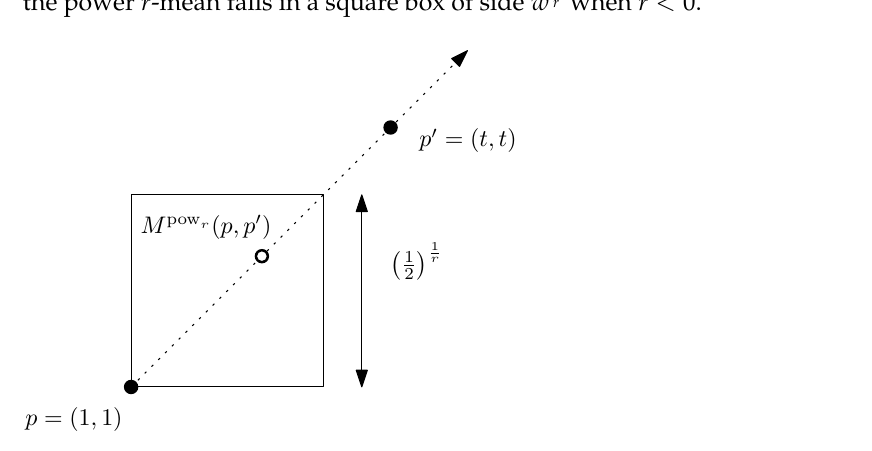
Figure 2. Illustration of the robustness property of the r -power mean M pow r ( p , p (cid:48) ) when r < 0 for two points: a prescribed point p = ( 1,1 ) and an outlier point p (cid:48) = ( t , t ) . When t → + ∞ , the r -power mean of p and p (cid:48) for r < 0 (e.g., coordinatewise harmonic mean when r = − 1) is contained inside the (cid:16) (cid:17) 1 r . The r -power mean can be interpreted as a left-sided Bregman 1 box anchored at p of size length 2 x r + 1 when r < − 1 and F ( x ) = − log x when r = − centroid for F (cid:48) ( x ) = − x r , i.e., F ( x ) = − 1 r